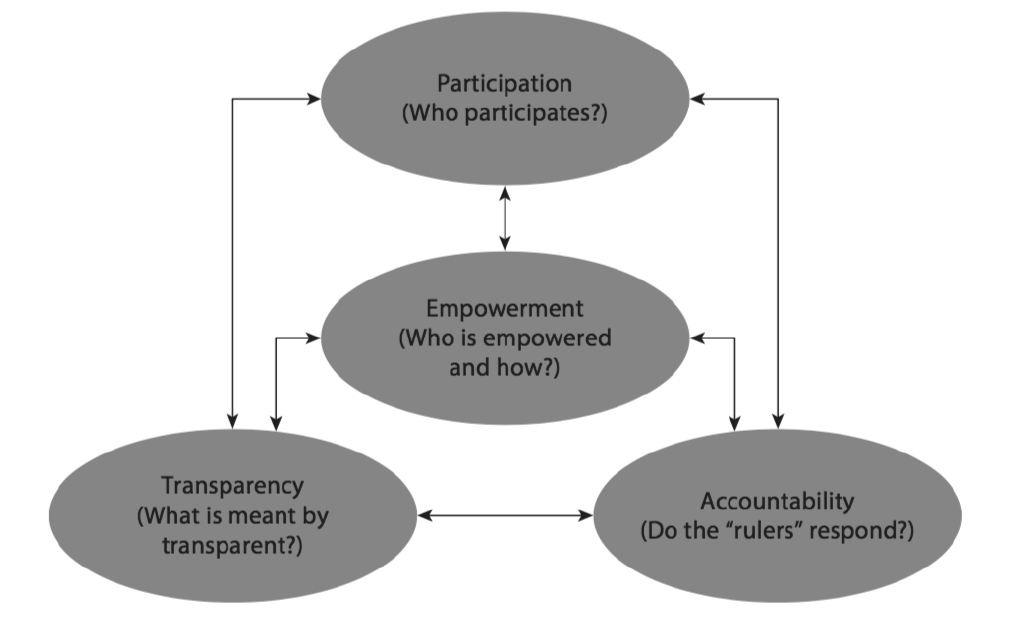
Figure 1: Questioned Relationships between Empowerment, Participation, Transparency, and